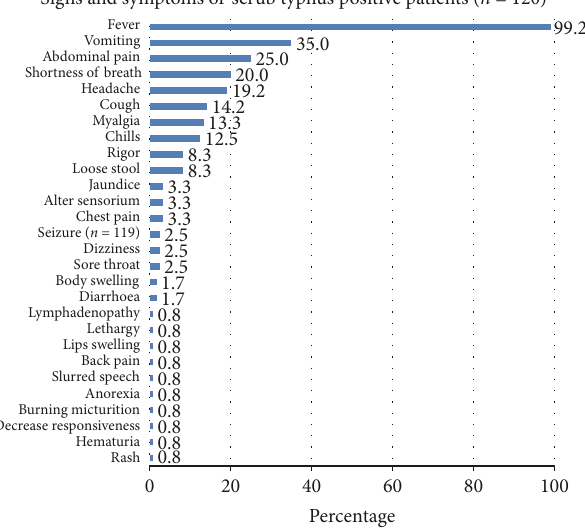
Figure 2: Signs and symptoms of scrub typhus positive patients.